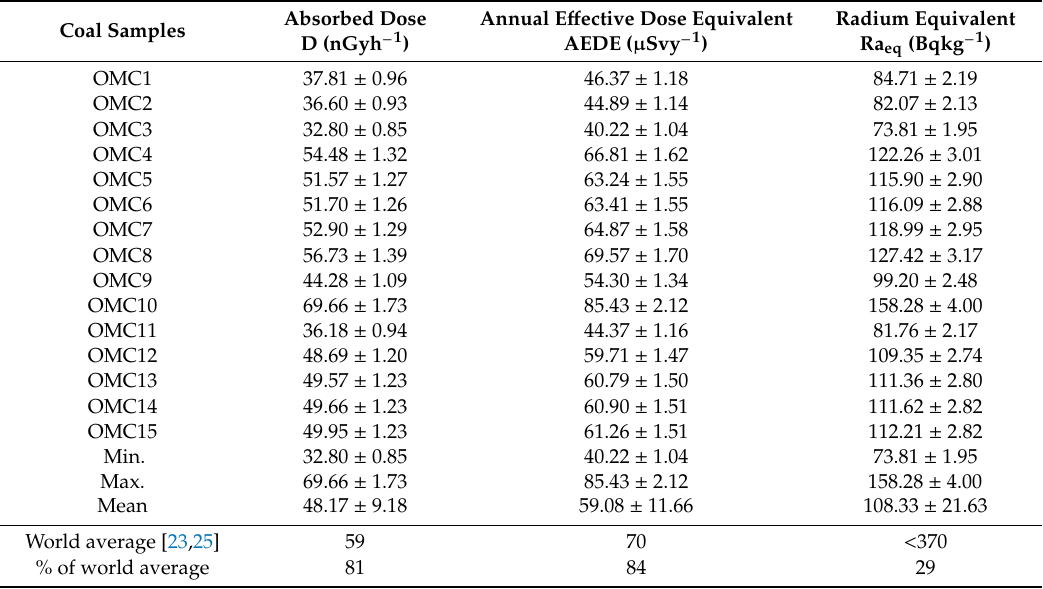
Table 5. Radiological hazard indices for radionuclides in Okaba coal samples. Coal Samples